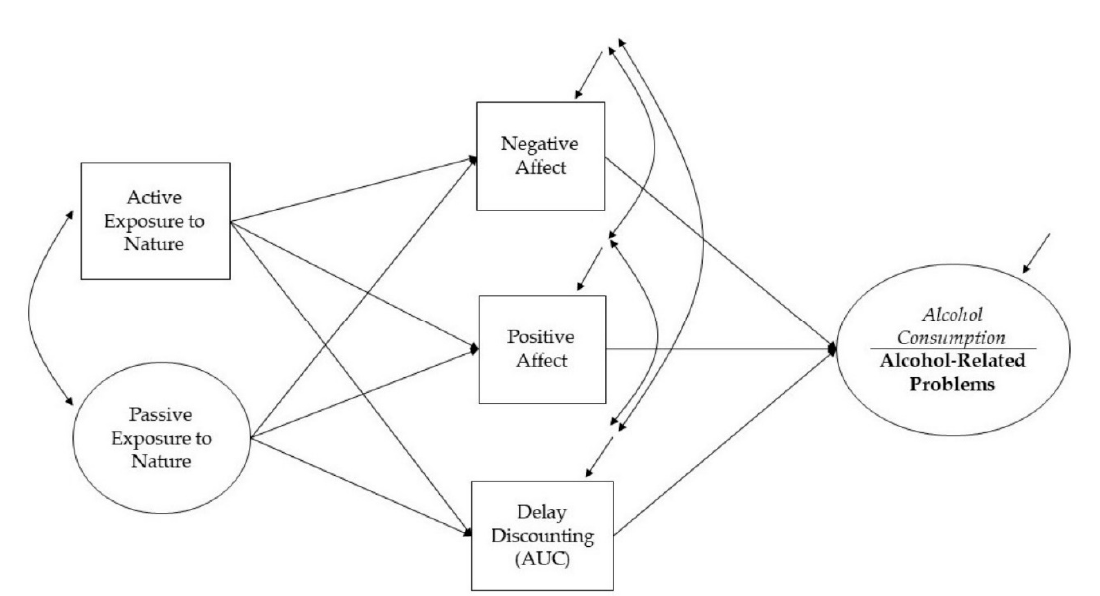
Figure 1. The hypothesized models. Alcohol consumption (model 1) and alcohol-related problems (model 2) regressed on negative affect, positive affect, and delay discounting, which in turn regressed on active exposure to nature and passive exposure to nature.